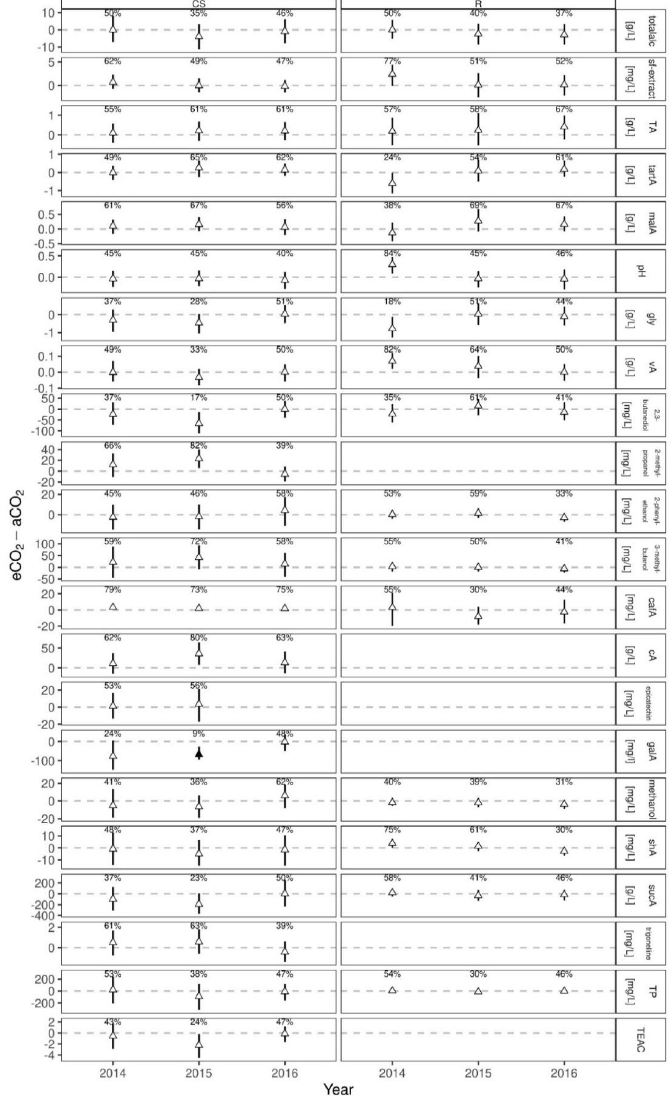
Figure 5. Posterior predicted difference (median and 50% HDI) between eCO 2 and aCO 2 for each year of measurement from Bayesian generalized linear mixed effects models on wine analyses of Cabernet Sauvignon (CS) and Riesling (R). Percentages represent the probability of eCO 2 -aCO 2 > 0. Filled symbols indicate “significant differences”, if the probability is >90% (positive difference) or <10% (negative difference).